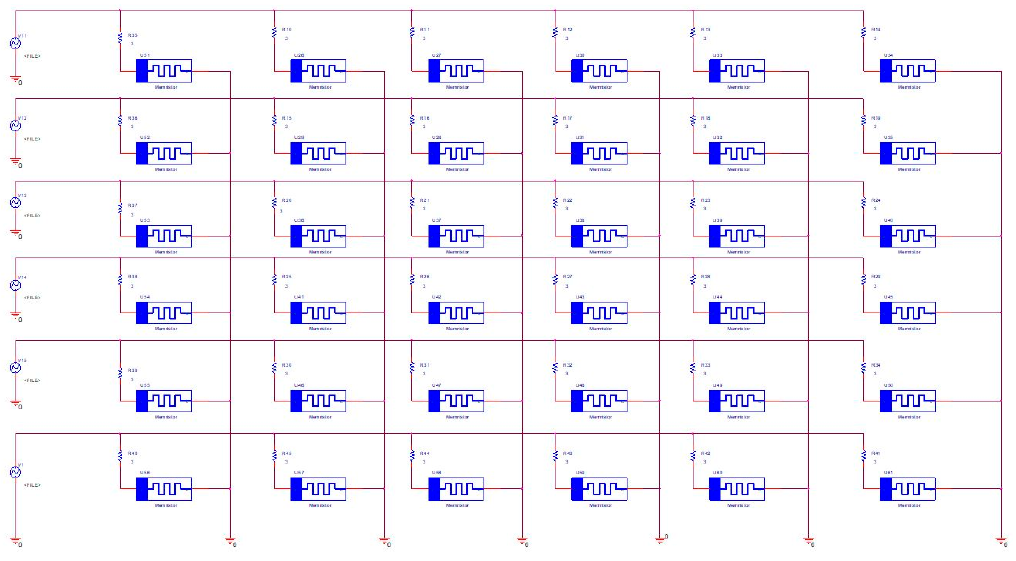
Figure 6. Current-voltage relationships of memristors in the hybrid memory crossbar for: ( a ) Biolek modified window function; ( b ) Joglekar modified window function; ( c ) Biolek original window function; ( d ) Joglekar original window function.